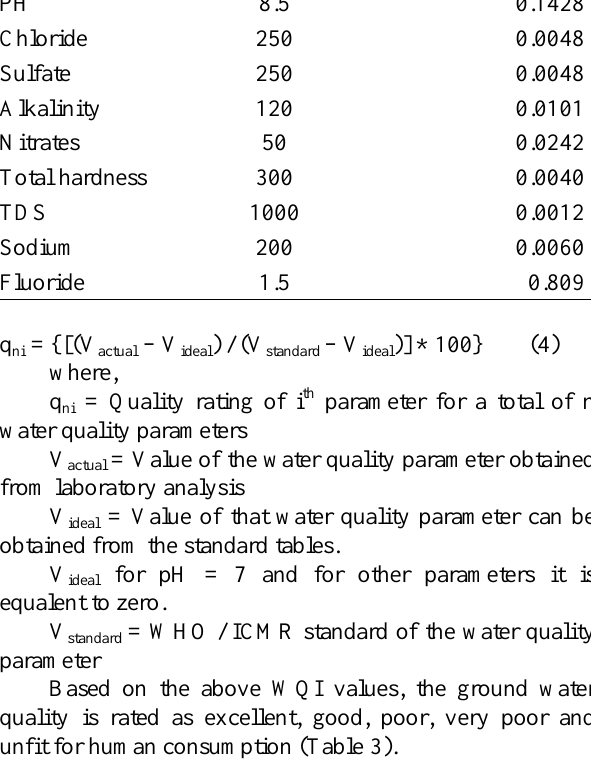
Table 3: Water Quality Index Categories